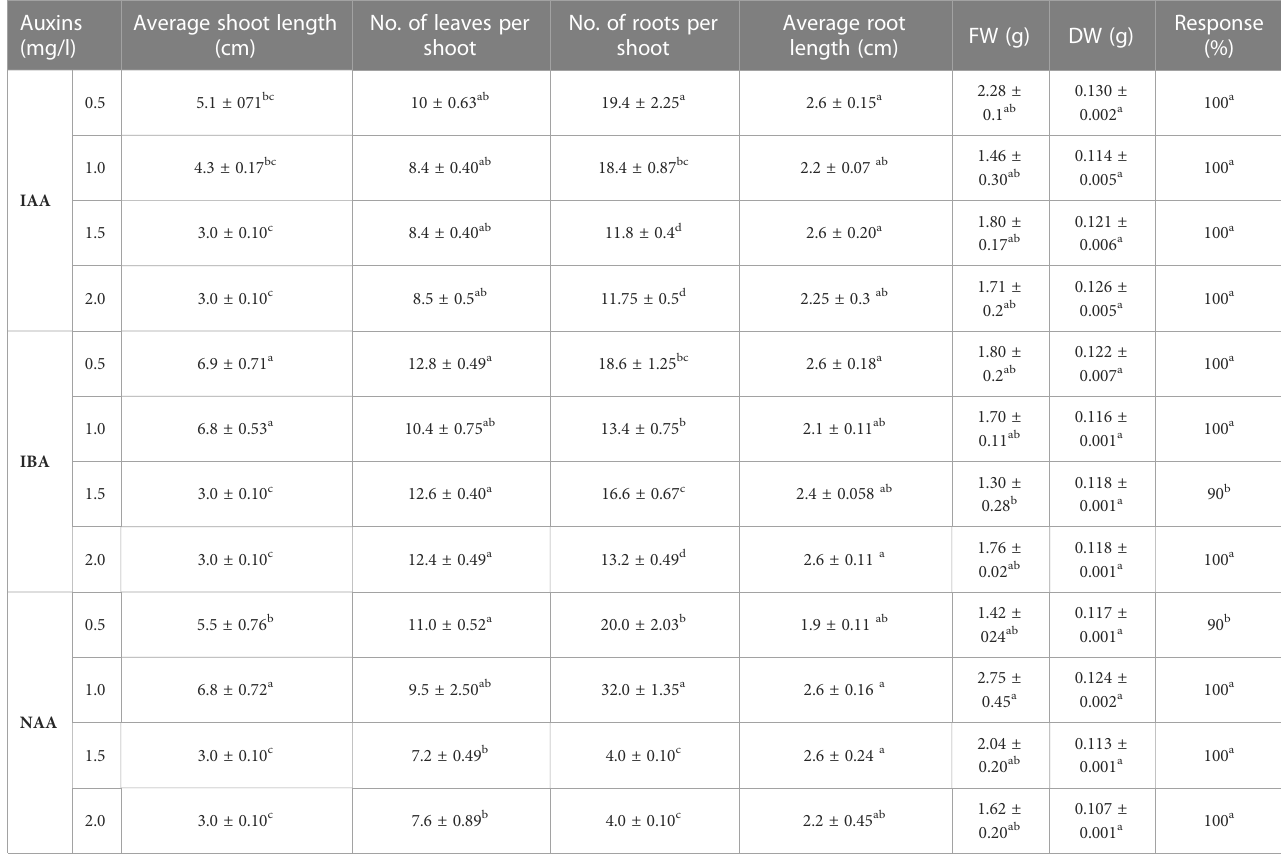
TABLE 2 Effect of auxins (IAA, IBA, and NAA) on regeneration of Bacopa fl oribunda . Auxins Average shoot length No. of leaves per (mg/l) (cm)